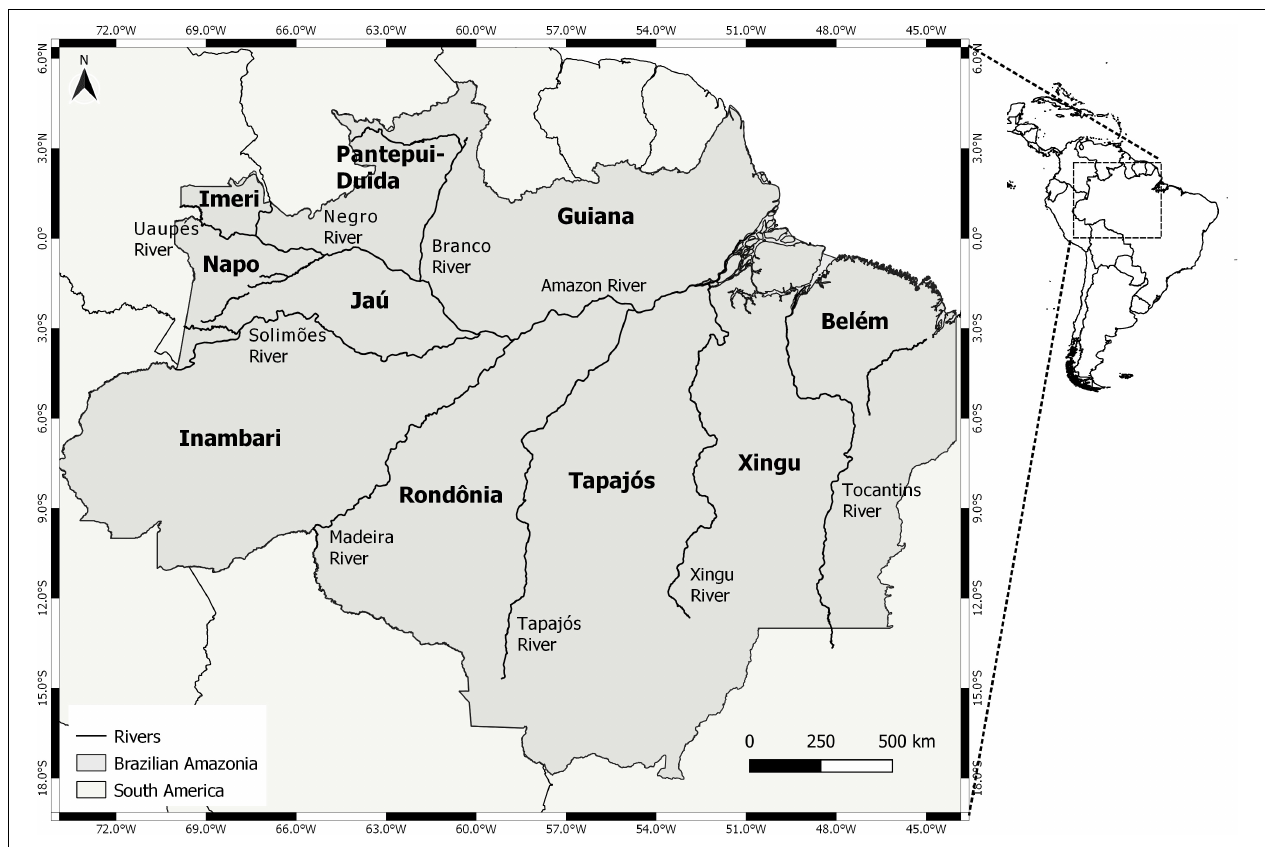
FIGURE 1 | Major interfluves of the Brazilian Amazonia, recognized as different biogeographic provinces.